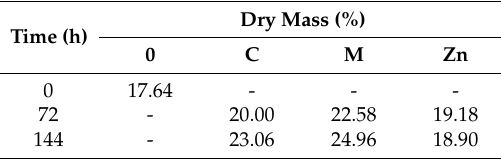
Table 1. The dry mass of cod fillets after 72 h and 144 h of storage.